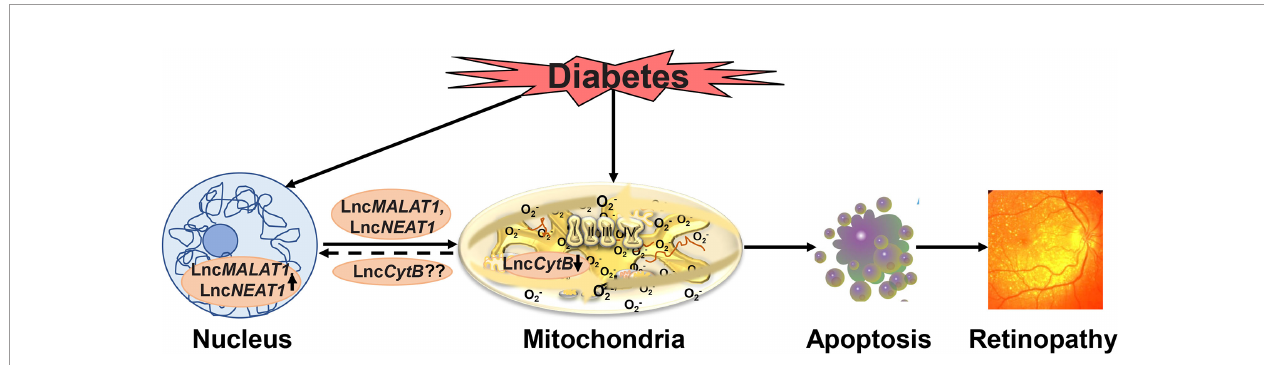
FIGURE 3 | Hyperglycemic environment damages mitochondria and also elevates levels of various nuclear genome encoded LncRNAs including Lnc MALAT1 and Lnc NEAT1. These LncRNAs, in addition to affecting metabolic abnormalities associated with diabetic retinopathy including in fl ammation, also move inside the mitochondria, and damage mitochondrial structural, functional and genomic stability. Furthermore, possible decrease in the mitochondrial genome encoded Lnc CytB further damages the mitochondria, and the damaged mitochondria accelerates apoptosis, ultimately, resulting in the development of diabetic